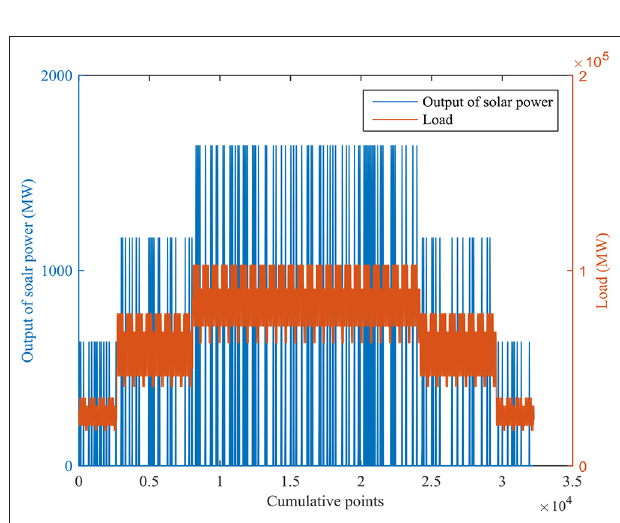
FIGURE 8 | Relationship between Solar Power output and